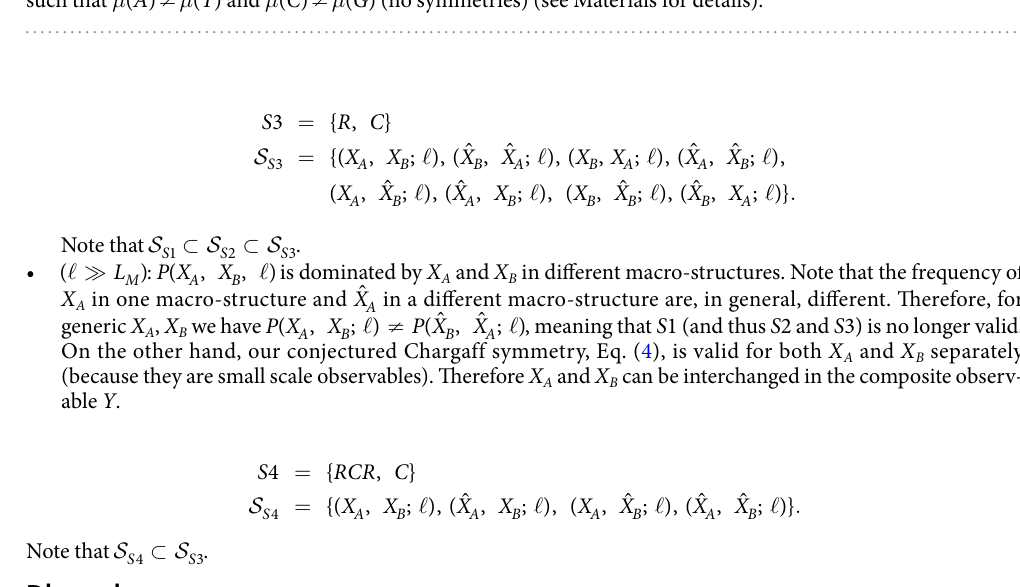
Figure 6. Hierarchy of symmetries in a synthetic sequence generated by the domain model. The analysis of a synthetic genetic sequence generated by our model reproduces the hierarchy of symmetries observed in the human genome (compare the two panels to Figs 1 and 3). The synthetic sequence is obtained following steps (1)–(3) of the main text. As main stochastic processes p we use Markov chains with invariant probabilities μ such that μ ( A ) ≠ μ ( T ) and μ ( C ) ≠ μ ( G ) (no symmetries) (see Materials for